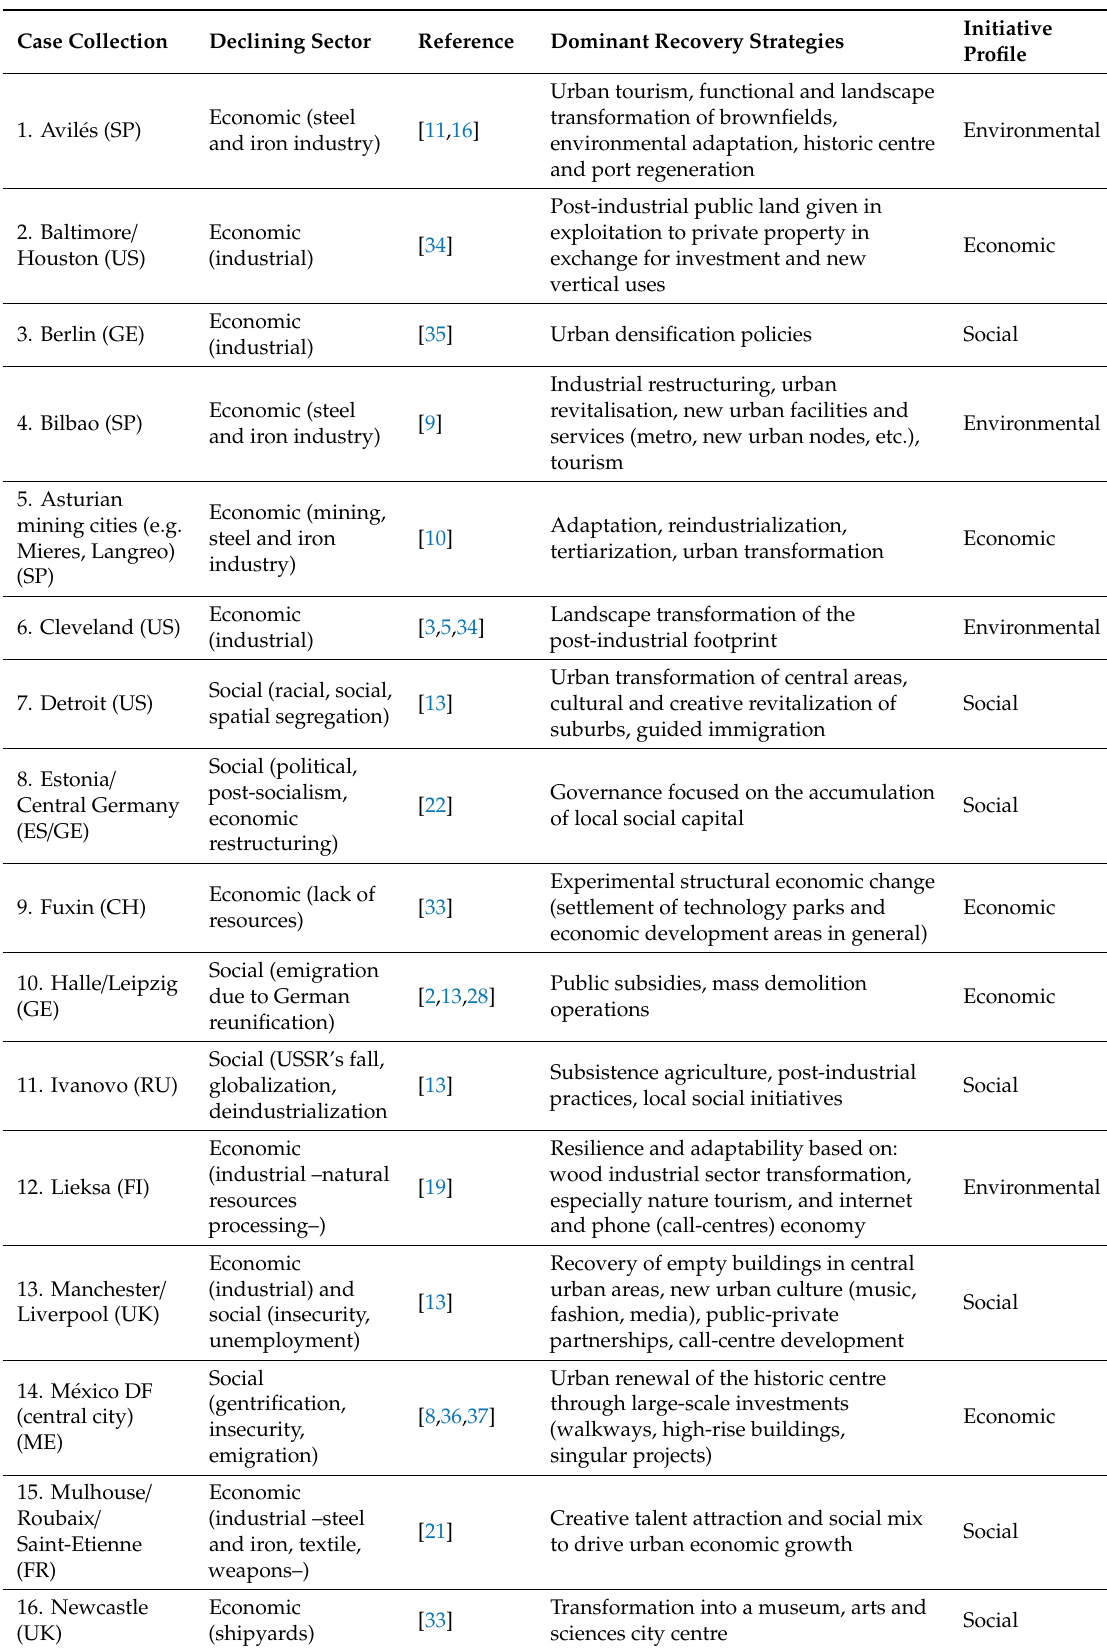
Table 2. Some successful city cases against urban